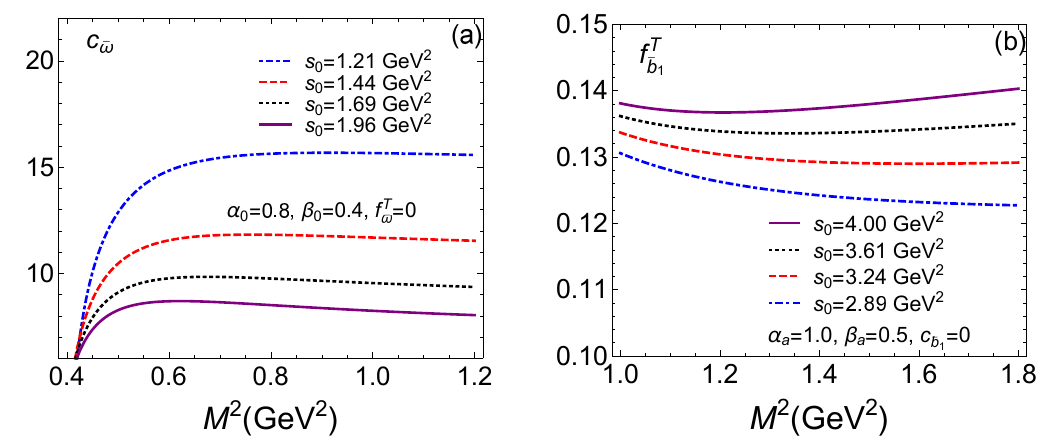
Figure 5 . Borel curve (a) for the meson pole residue f T ¯ ¯hy. coupling c . ¯ b 1